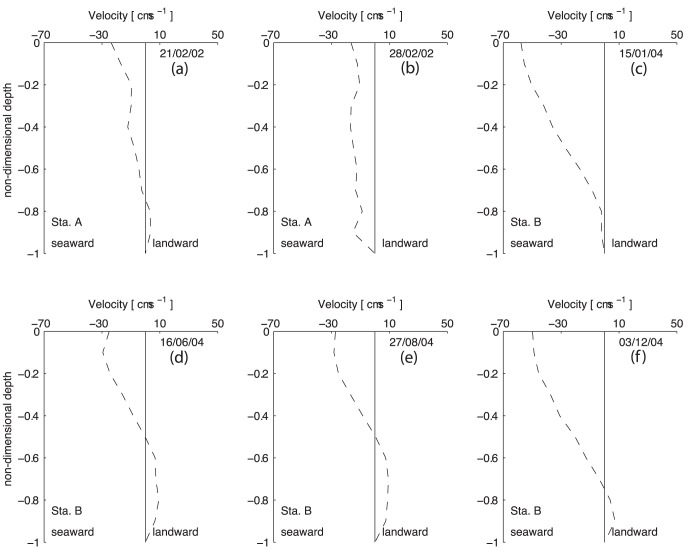
Profiles of non-tidal velocity at stations A and B.